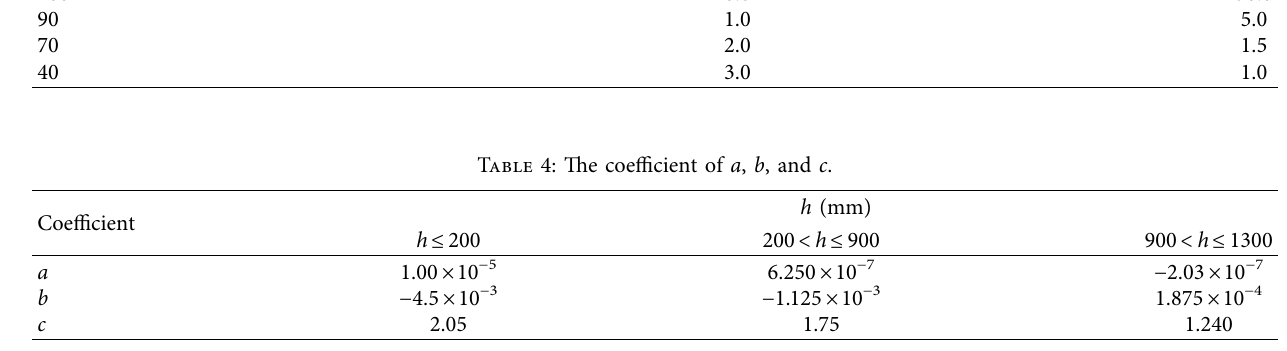
Table 5: The coefficient of C , D , q